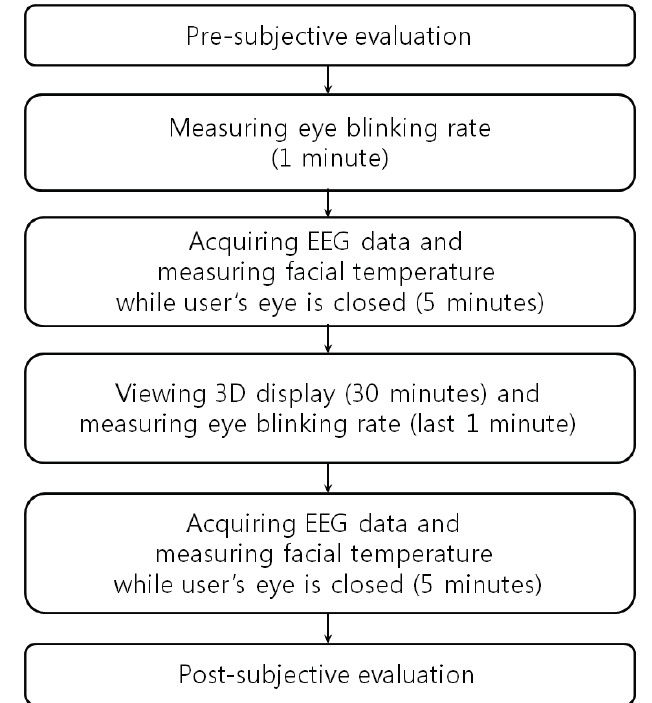
Figure 1. Experimental procedures used in our